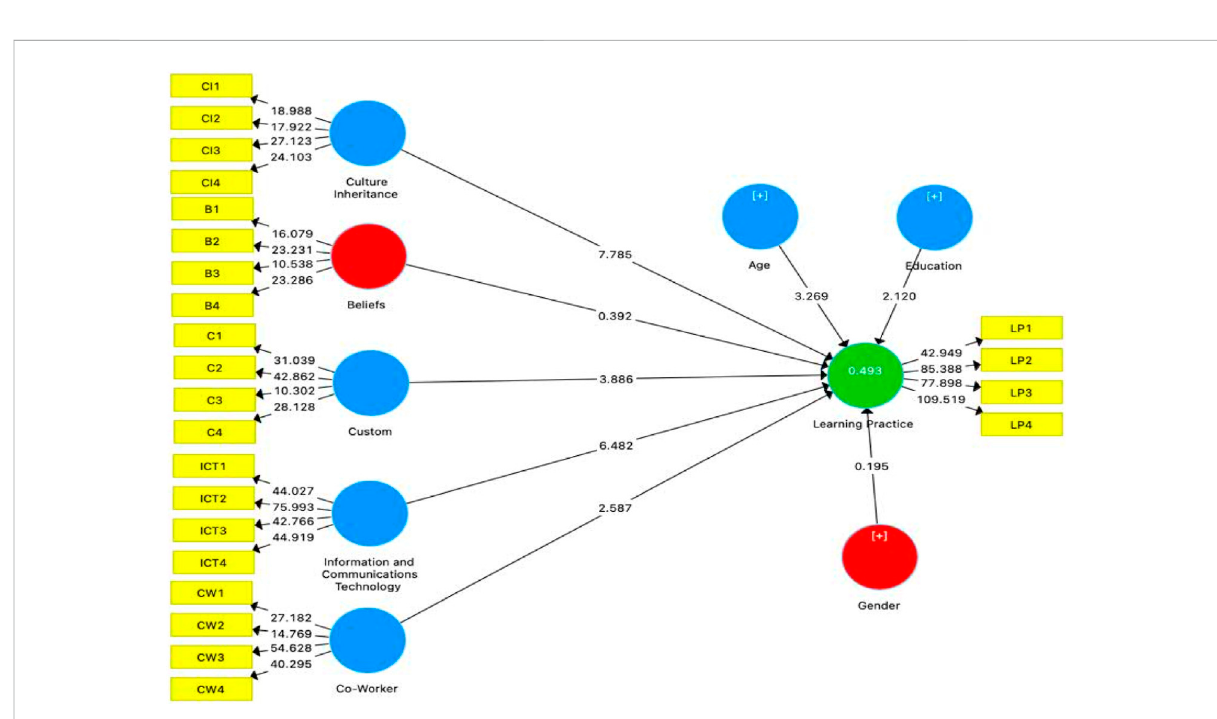
FIGURE 3 PLS-SEM Path Model (Green and blue variables = Signi fi cant; Green and red variables = Insigni fi